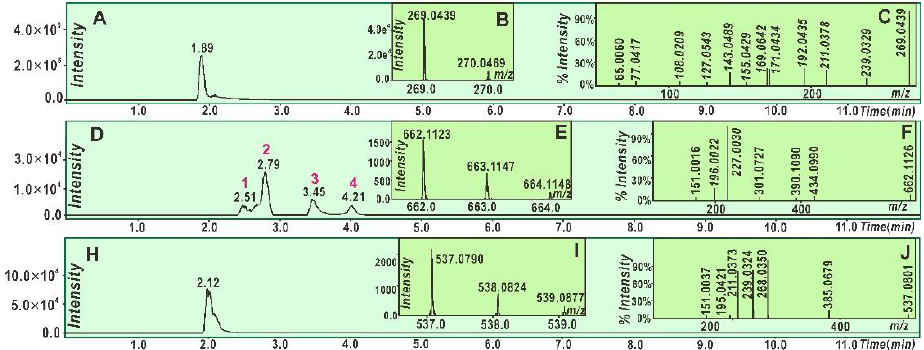
Figure 3. Main results of galangin in the UPLC−ESI−Q−TOF−MS/MS analysis: ( A ) total ion chromatographic diagram of galangin; ( B ) primary MS spectra of galangin; ( C ) MS/MS spectra of galangin; ( D ) total ion chromatographic diagram of the RAF products of galangin with DPPH • ; ( E )